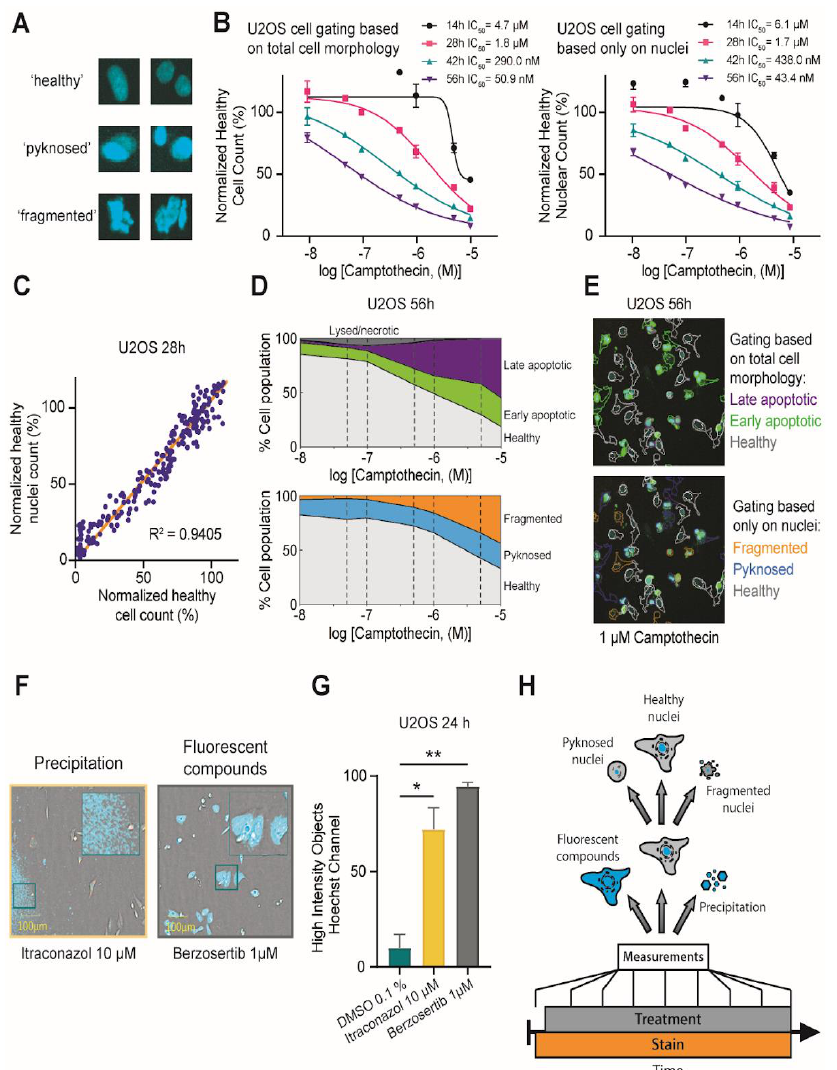
Figure 2. Analysis of Cell Nuclei by Hoechst Channel Intensity level. ( A ) Nuclei classification in healthy, pyknosed and fragmented by trained cell biologist. ( B ) Normalized healthy cell count and normalized healthy nuclear count of different concentrations (0.01 µ M, 0.05 µ M, 0.1 µ M, 0.5 µ M, 1 µ M, 5 µ M, 10 µ M) of camptothecin exposure with calculated IC50 values after 14 h, 28 h, 42 h and 56 h. ( C ) Correlation between the healthy cell count and the healthy nuclei count after 28 h of compound exposure normalized to healthy cells exposed to DMSO 0.1% in U2OS cells. ( D ) Fractions of HighVia gating and fractions of healthy, fragmented and pyknosed nuclei after exposure to different concentrations (0.01 µ M, 0.05 µ M, 0.1 µ M, 0.5 µ M, 1 µ M, 5 µ M, 10 µ M of camptothecin in U2OS cells after 56 h of compound exposure. Error bars show SEM of three technical replicates. ( E ) Fluorescence image of different gatings of U2OS cells exposed to 1 µ M camptothecin after 56 h based on total cell morphology and based on nuclei. ( F ) Bright field confocal image of stained (blue: DNA/nuclei, green: Annexin V apoptosis marker, red: YoPro3, magenta: Mitotracker Deep Red, mitochondria content) U2OS cells after 24 h of compound exposure (itraconazole 10 µ M, berzosertib 1 µ M). Precipitation of 10 µ M itraconazole and fluorescence of 1 µ M berzosertib exposure shown as Hoechst High Intensity Objects are highlighted. ( G ) Hoechst High Intensity Objects after 24 h of compound exposure (itraconazole 10 µ M, berzosertib 1 µ M) and DMSO 0.1% as negative control. Error bars show SEM of three technical replicates. ( H ) Generic workflow of cell gating based on cell